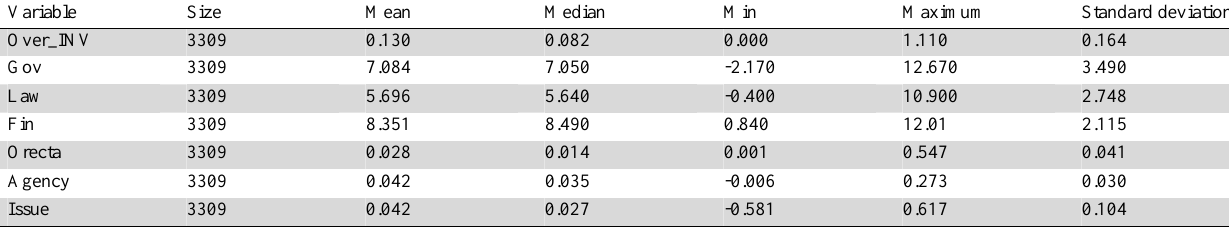
Descriptive Statistics of Variables in Model